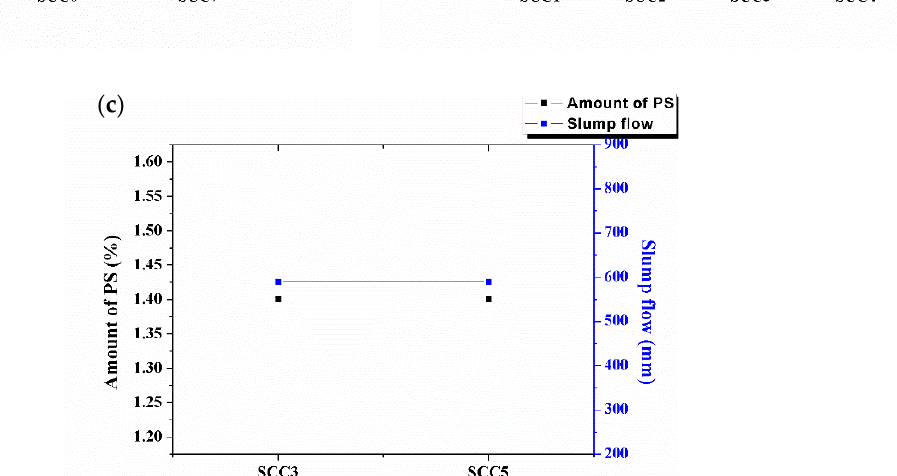
Figure 3. Different influence factors on amount of PS and slump flow of SCCs. ( a ) amount of GDS; ( b ) W/B; and ( c ) amount of sodium sulfate.